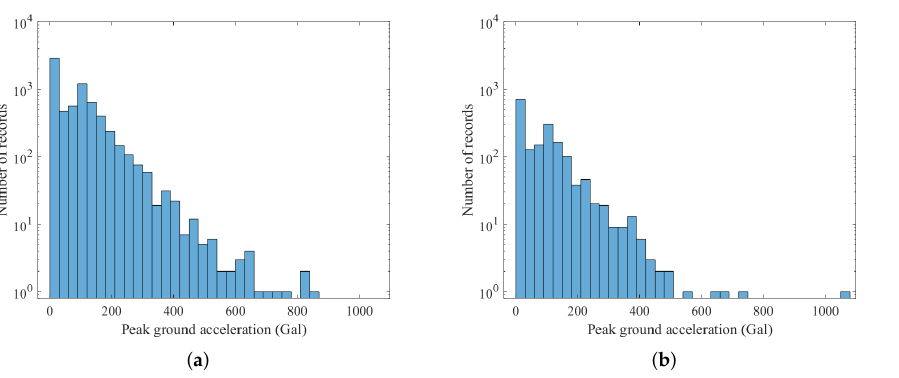
Figure 4. The PGA histograms of the datasets used for training and testing. ( a ) The PGA histogram of the training dataset. ( b ) The PGA histogram of the testing